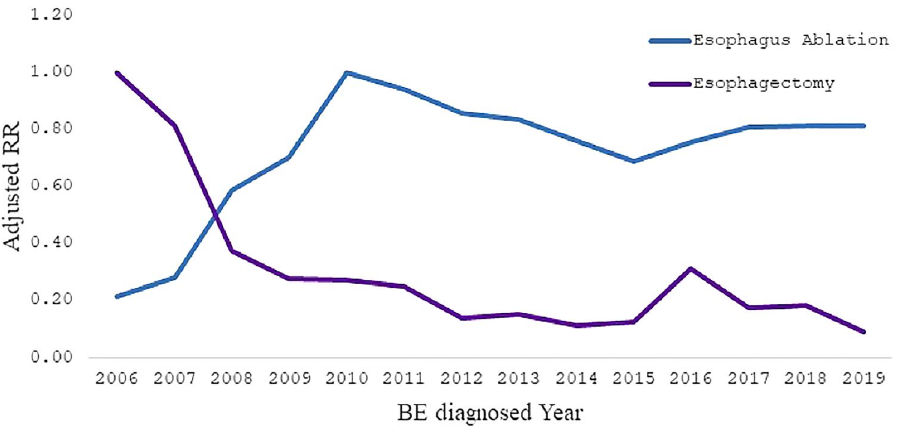
Figure 1. Trends in ablation versus esophagectomy from 2006 to